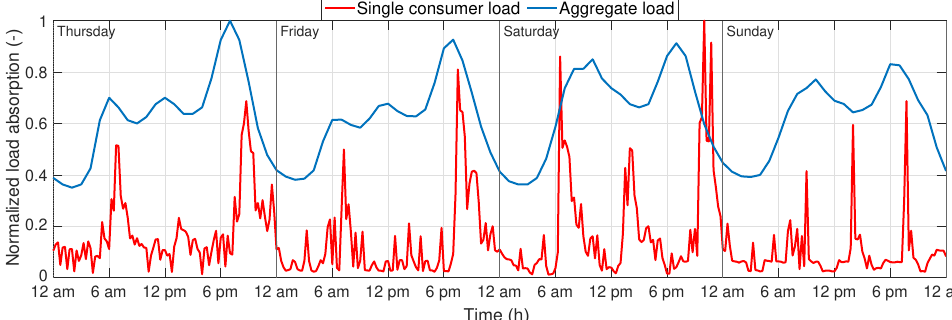
Figure 3. Examples of load profiles: single consumer load and aggregate absorption of about 100